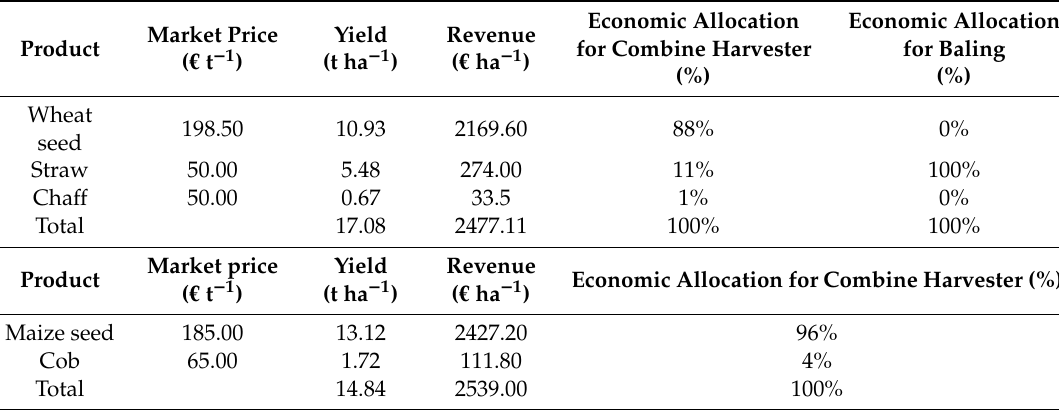
Table 3. Economic allocation used for the cost analysis of products and by-products collected during both tests and each harvesting phase, with Harcob